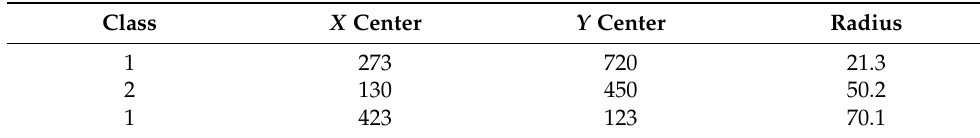
Table 2. Example of LXYR anotation file format.